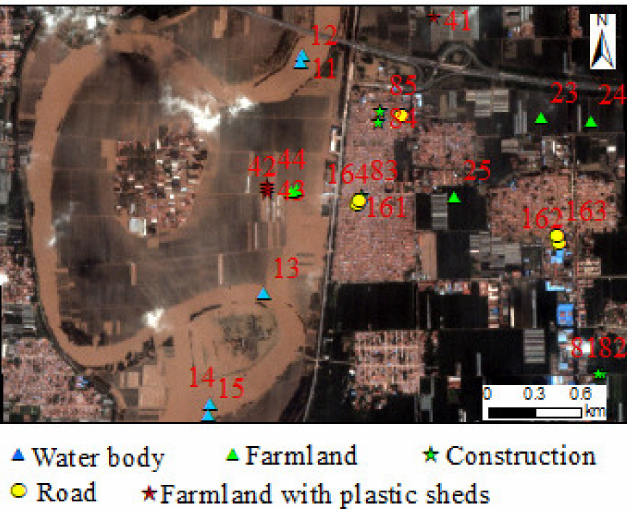
Figure 10. Sample points in rainy scenarios. The base map was a Planet RGB composite image dated 21 August 2018.